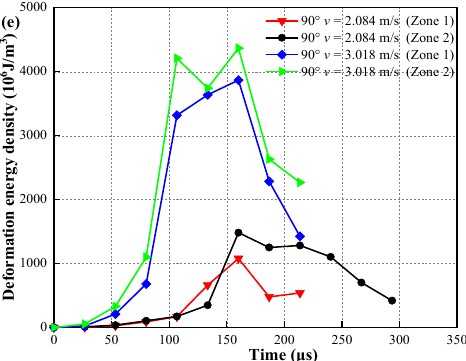
Figure 18. Deformation energy density evolution curves of coal specimens. ( a ) 0°, ( b ) 22.5°, ( c ) 45°, ( d ) 67.5°, ( e ) 90°.